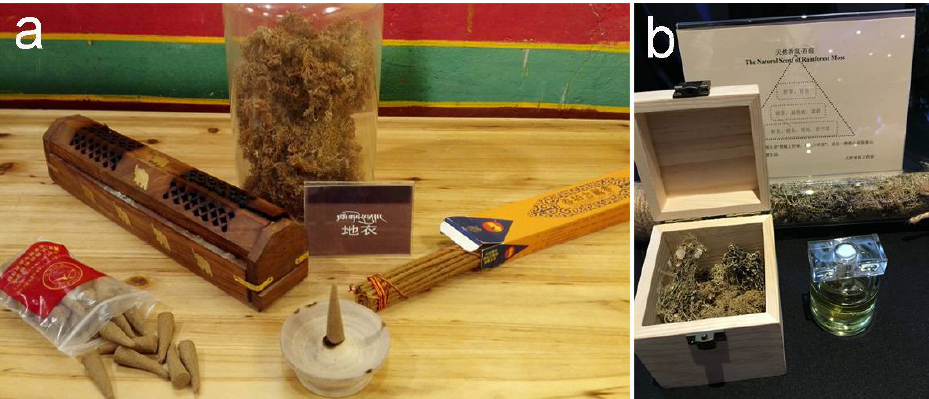
Figure 5. ( a ) Lethariella , used for Tibetan incense; ( b ) Usnea and Sulcaria , used for raw materials of perfume in Yunnan; ( a ) Photographed by Mei-Xia Yang; ( b ) photographed by Li-Song